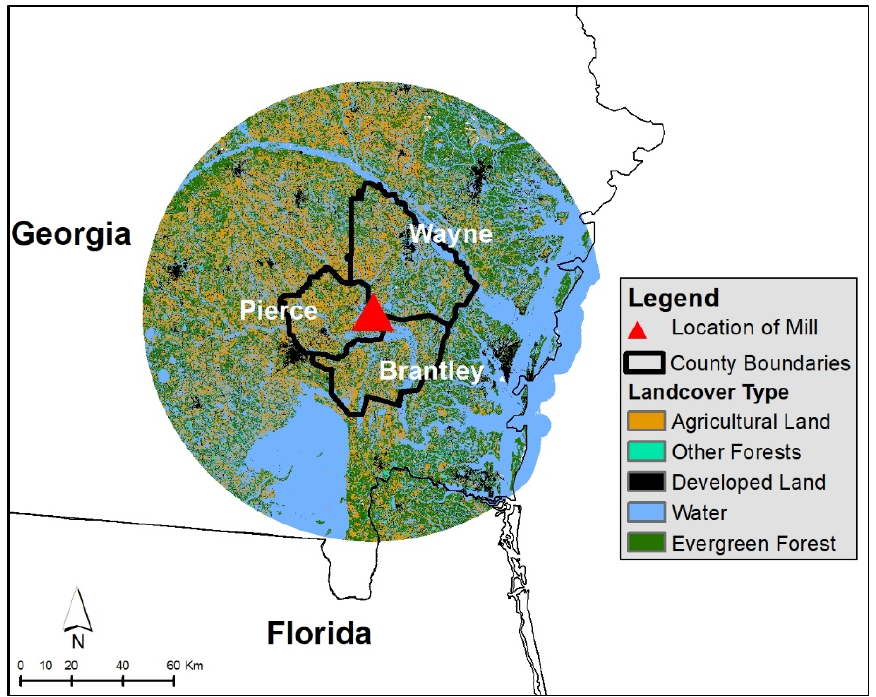
Figure 1. Location of the pulp mill, selected initial sourcing radius (90 km), and the spatial distribution of evergreen forestlands [31].